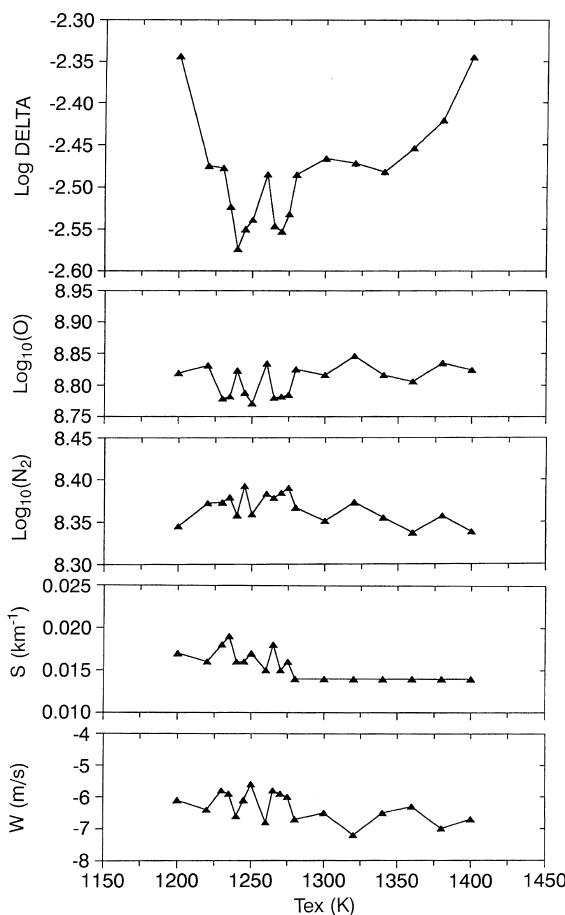
Fig. 6. A one-dimensional cut along the T ex axis of the DELTA surface to illustrate the search for a DELTA global minimum ( top panel ) and calculated log[O], log[N 2 ], S and W variations in the considered T ex range; the density units are cm (cid:255)